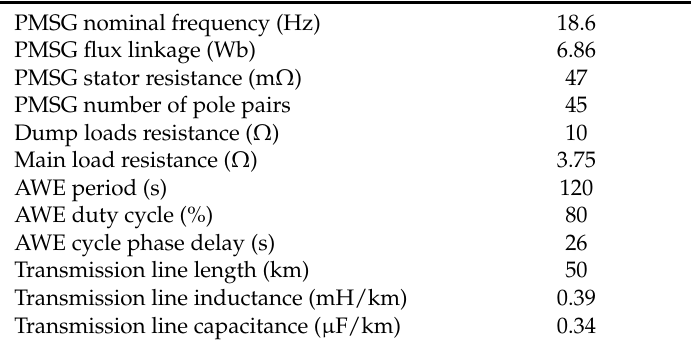
Figure 3. Power system diagram of the simulated offshore non-reversing pumping mode AWE farm. Table 1. Simulation model specification [19].